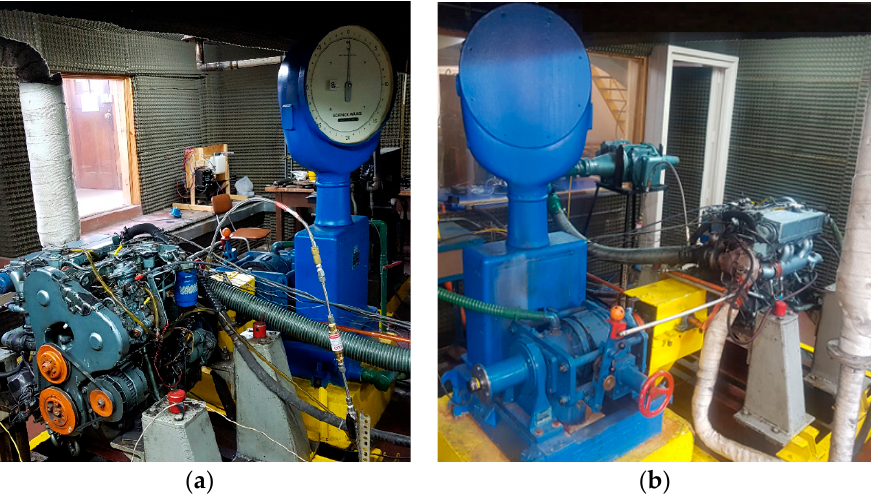
Figure 2. UTFSM test engine facility: ( a ) Front view and ( b ) back view.